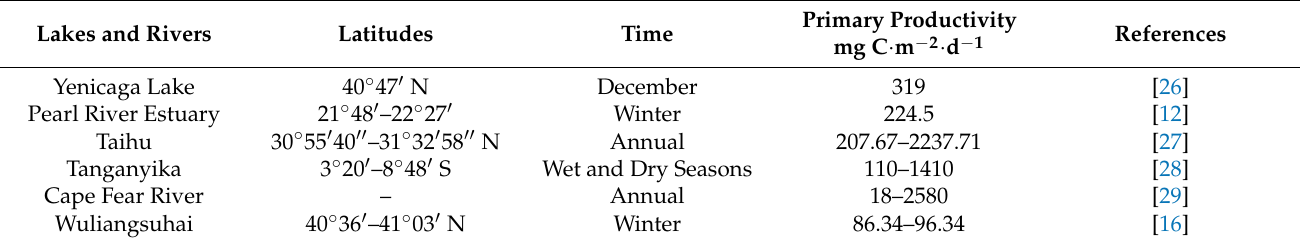
Table 1. Previous studies of primary productivity using the VGPM